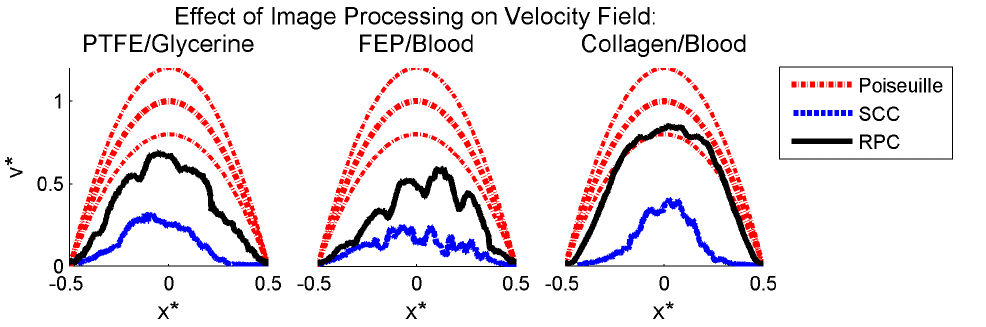
Figure 4. Effect of image preprocessing on PIV accuracy. Mean velocity profiles obtained using standard PIV correlation applied to raw images (dashed blue lines) and processed images (solid black lines) are plotted with the volume-adjusted Poiseuille solution (dashed red lines) for each experimental case. The uncertainty based on measured flow rate and vessel diameter is plotted for the theoretical solution (upper and lower dashed red lines). The 95% confidence interval on the mean for the experimental data is not distinguishable from the mean. Left to right: glycerine-perfused PTFE, blood-perfused FEP, and blood-perfused collagen. Data shown is averaged in time and along the length of the vessel and is normalized for each experimental case by the vessel diameter and theoretical maximum